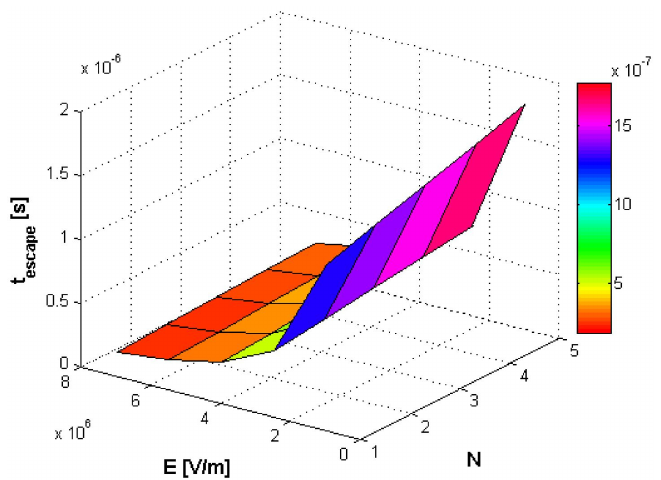
Figure 5. Simultaneous influence of both external electric field E (in the range [10 6 , 8 ∗ 10 6 ]) and monomers number N of polymer (in the range [1, 5]), on the translocation time.